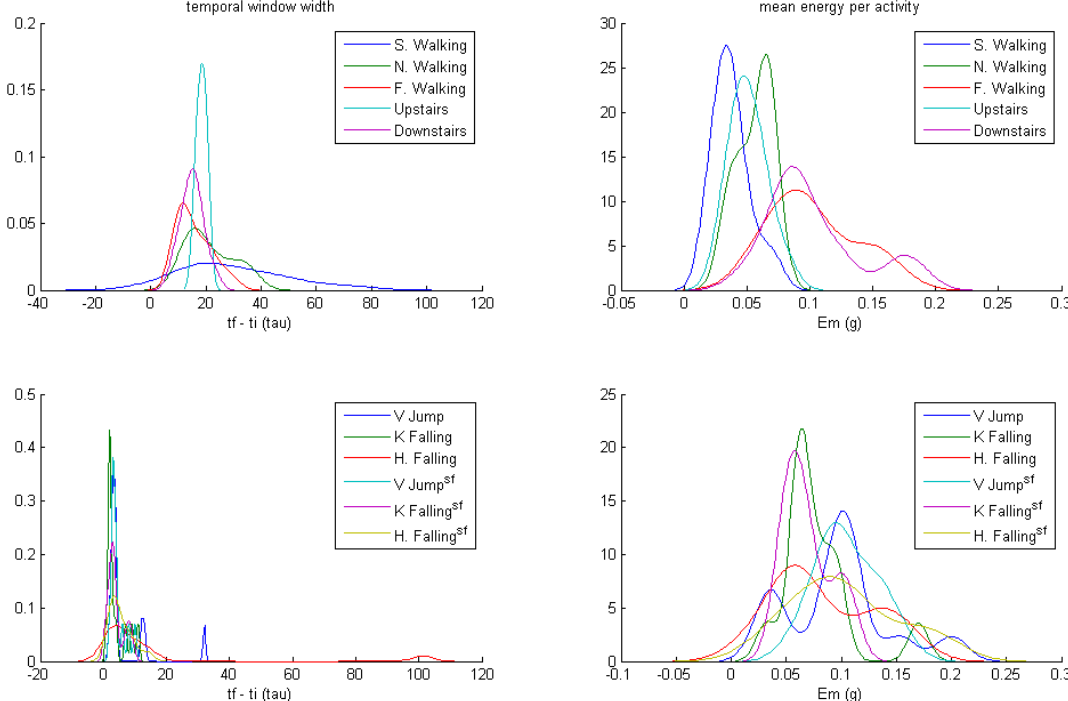
Figure 5. Density plots of temporal window width, and mean energy per type of activity (measured in sensor axis with higher energy), for the non-personalized study. Top: non-impact activities. Bottom: impact activities. sf Soft floor.